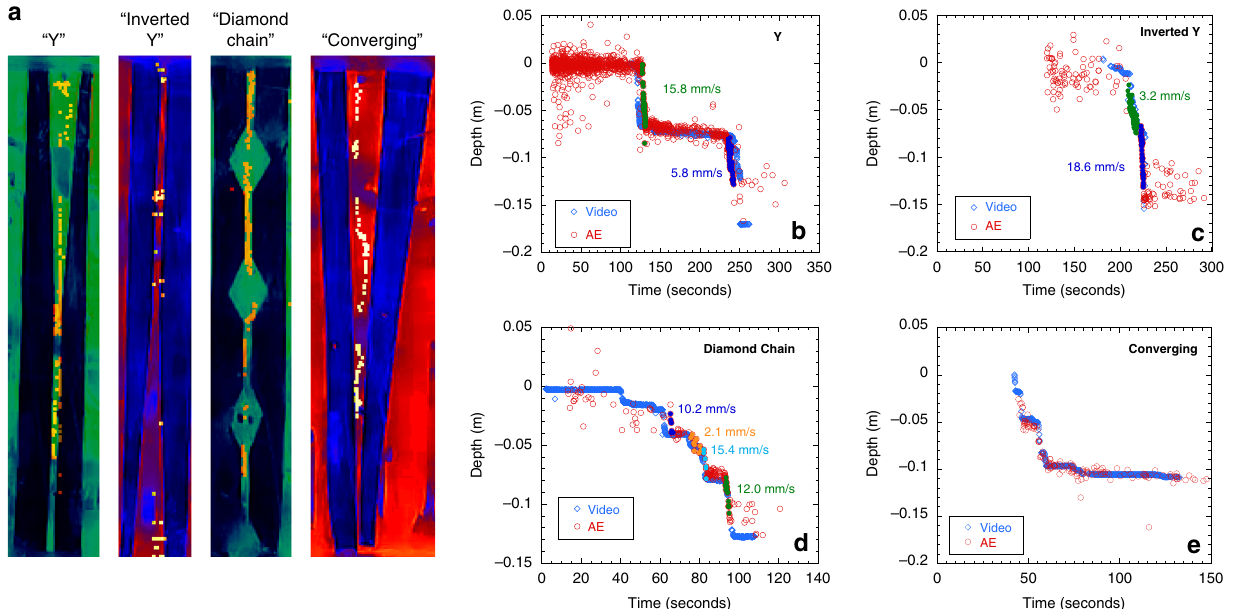
Fig. 6 Dust speed controlled by fracture aperture. a The false-color image of the actual fractures with yellow-orange dots indicating the location of the chattering dust during descent, (see Supplementary Fig. 8c for dimensions.) Location of chattering dust grains as a function of time from video imaging (blue diamonds) and acoustic emission (AE open red circles) are shown for b converging Y-shaped aperture, c diverging (inverted Y) aperture, d diamond chain, and e narrowing-aperture fracture (converging). Out-of-plane aperture was 2 mm in all